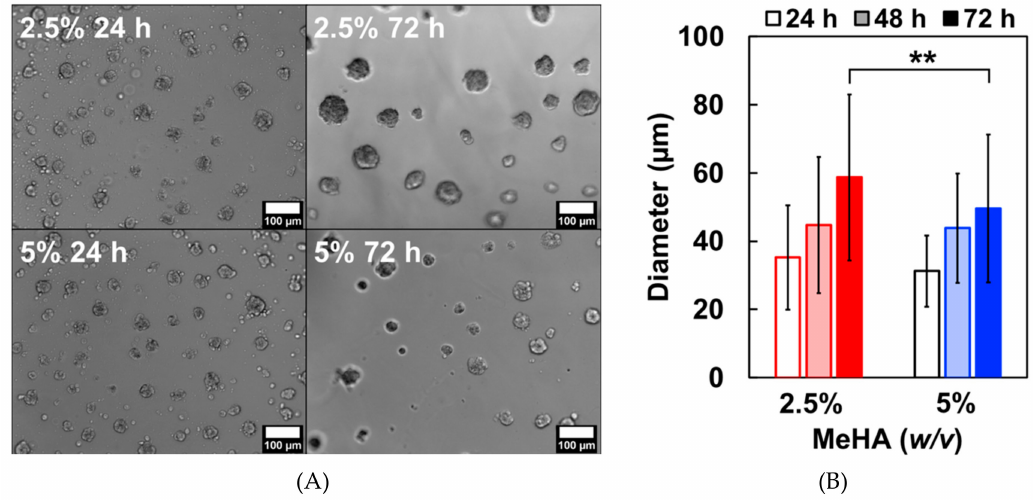
Figure 5. Proliferation of ReNcell VM cell clusters on laminin-coated crosslinked x-MeHA hydrogel surfaces. ( A ) The spheroids grew in size over time, as observed under live-cell microscopy. ( B ) After 72 h, spheroids on the softer 2.5% w / v x-MeHA hydrogels were significantly larger (** p < 0.01) compared to those on the 5% w / v x-MeHA hydrogels. Errors bars depicted as standard deviation (S.D.). Scale bar is 100 µ m. n ≥ 3 per